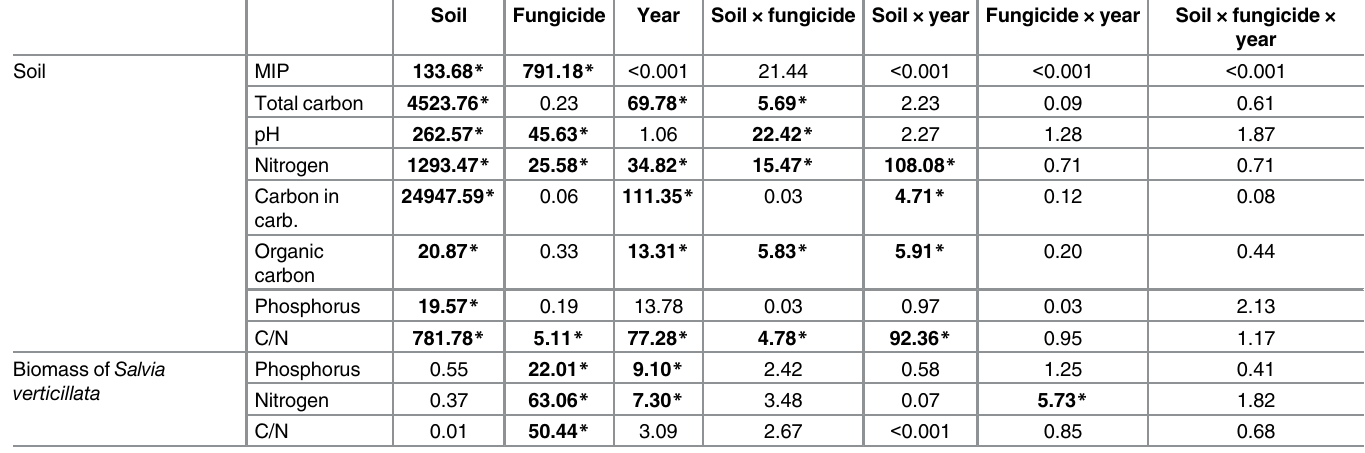
Table 2. The effects of soil type, fungicide and year on mycorrhizal inoculation potential of the soil, on chemical composition of the soil and on nutrient content of biomass of S . verticillata . Df Error = 48 for all tests. The values are deviance for MIP and F-values for the other tests. Significant values (p (cid:2) 0.05) are in bold and marked by * . A full table including p-values is given in S3